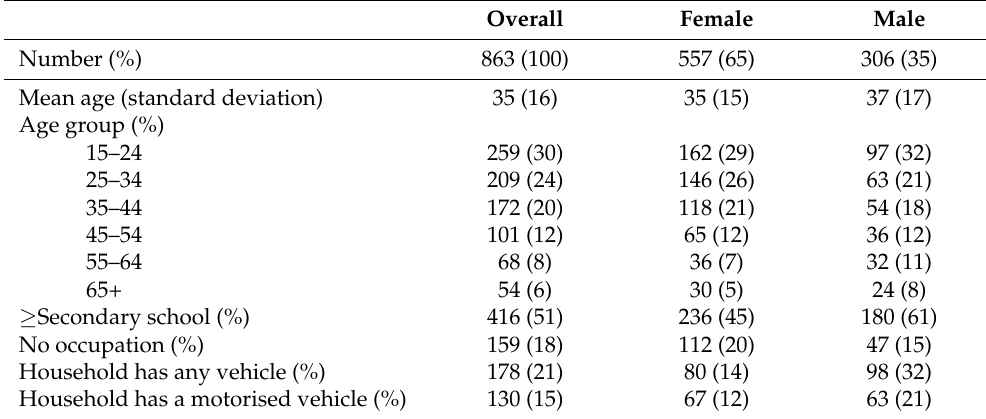
Table 1. Characteristics of participants surveyed for travel behaviour and physical activity stratified by sex in Accra, Ghana